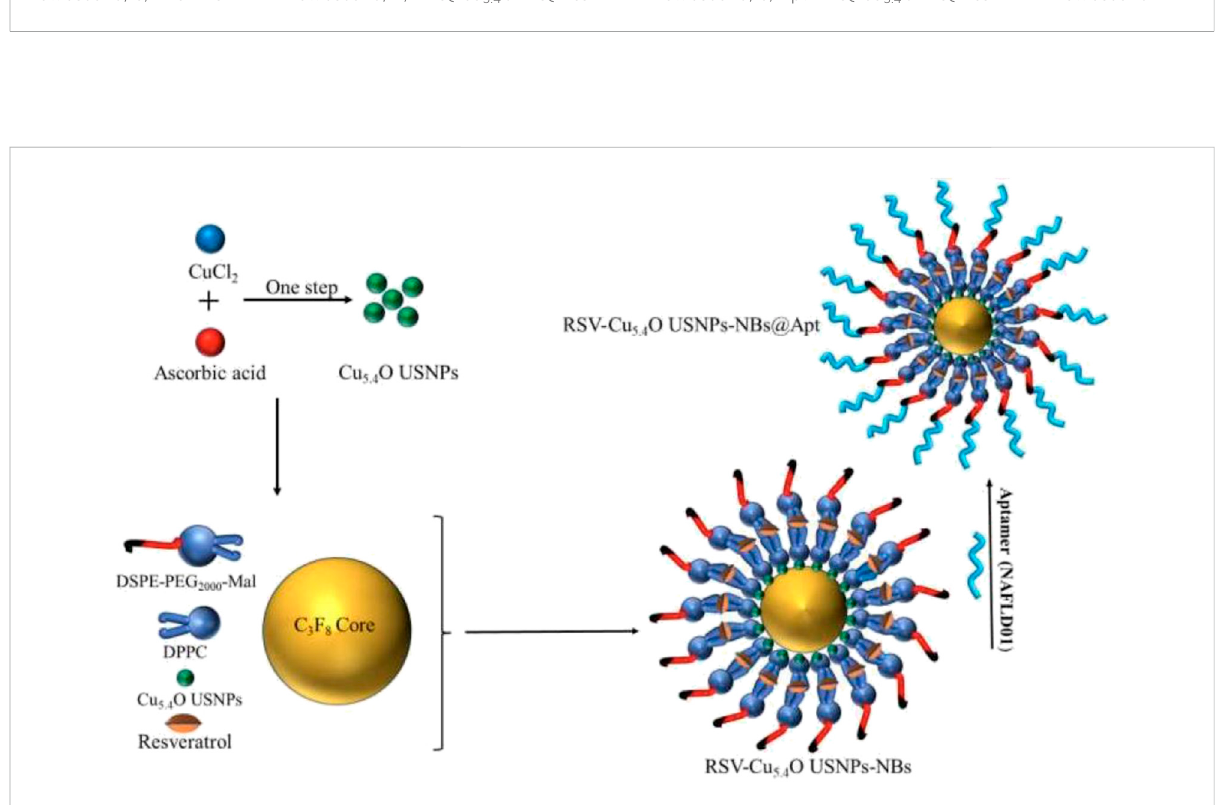
The linear calibration plot for TG concentration by ELISA method (A) and TG level after different treatment (B) ; 1) ultrasound; 2) FFA + ultrasound; 3) The NBs + FFA + ultrasound; 4) NBs@Cu 5.4 ONPs@Res + FFA + ultrasound; 5) Apt-NBs@Cu 5.4 ONPs@Res + FFA + ultrasound.